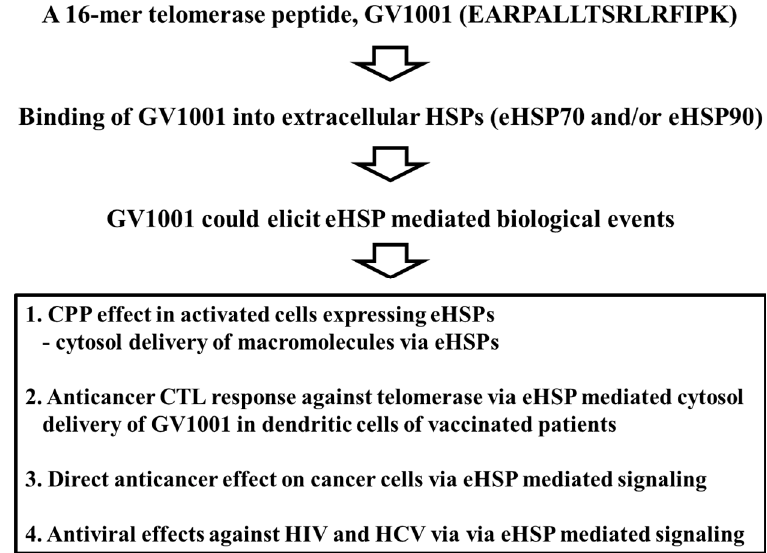
Figure 1. GV1001 could have various biological events via extracellular heat shock proteins (eHSPs).